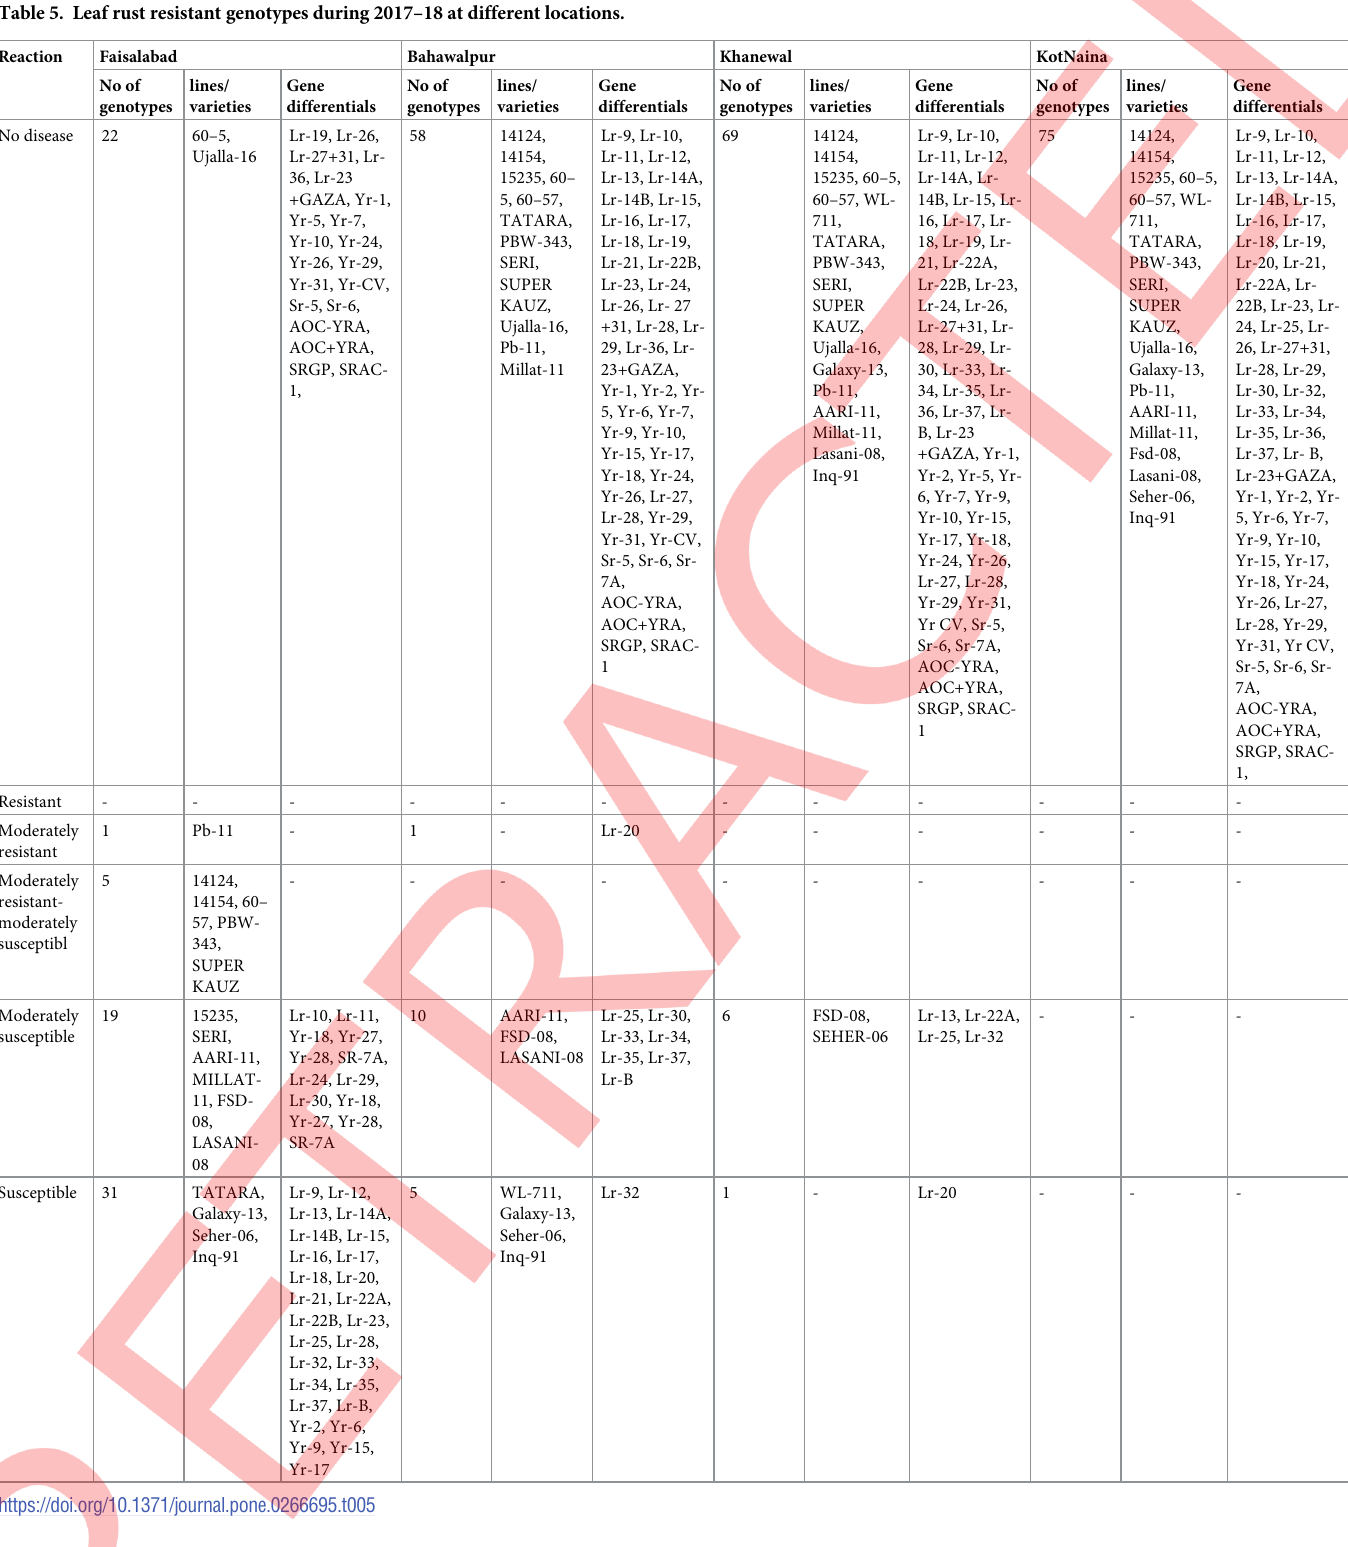
Table 5. Leaf rust resistant genotypes during 2017–18 at different